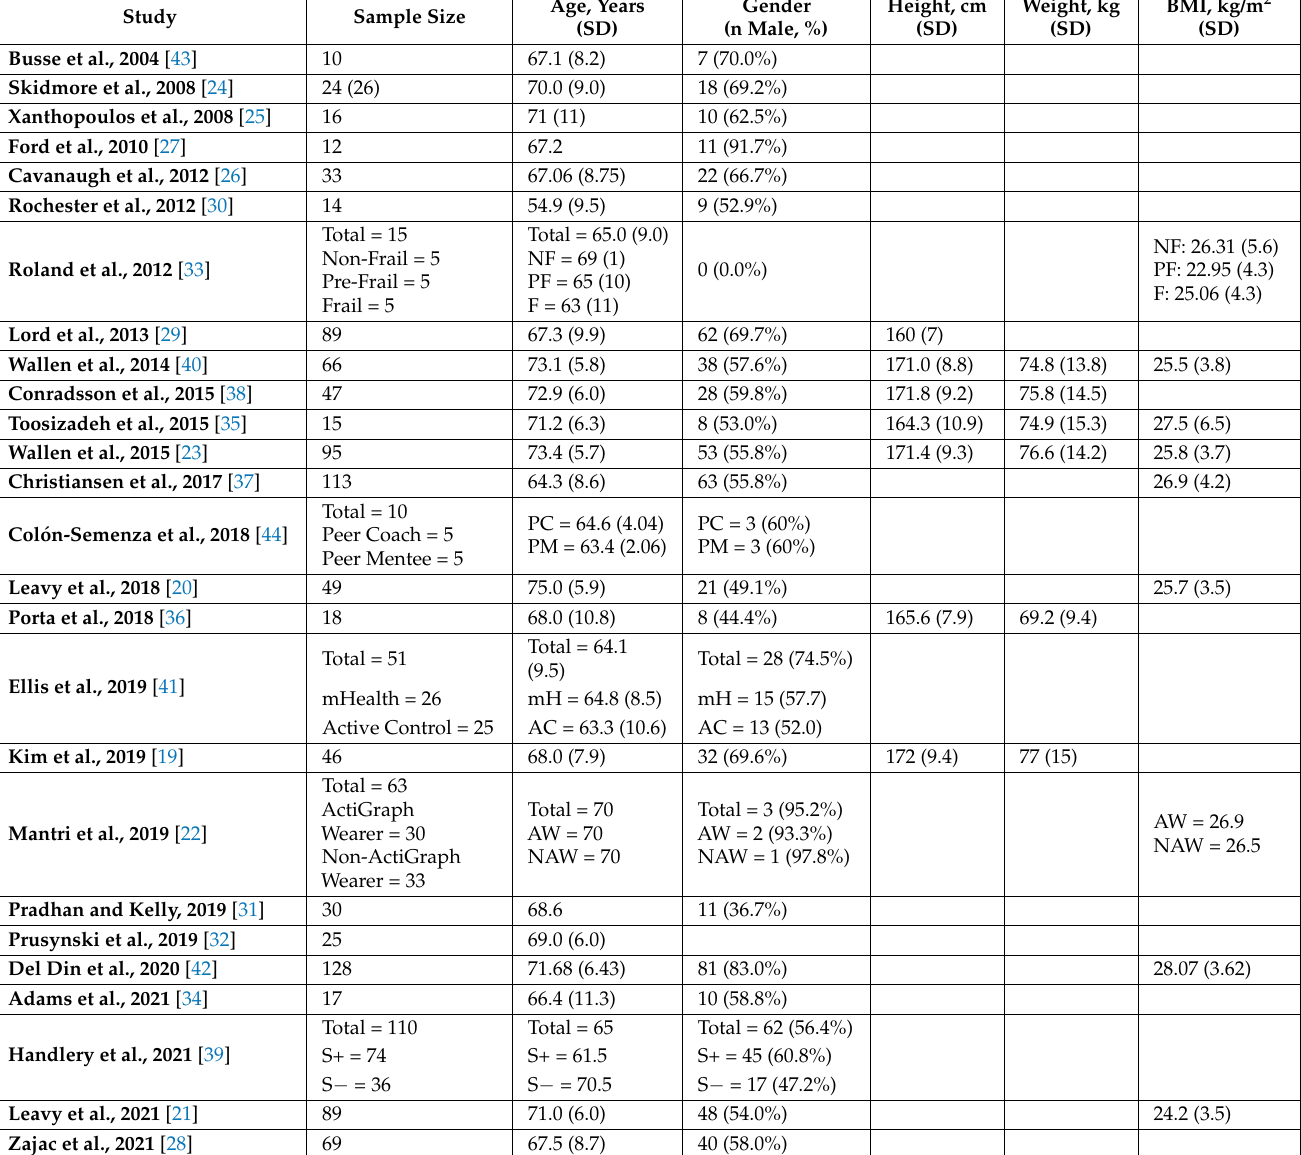
Table A1. Characteristics of patients and anthropometric